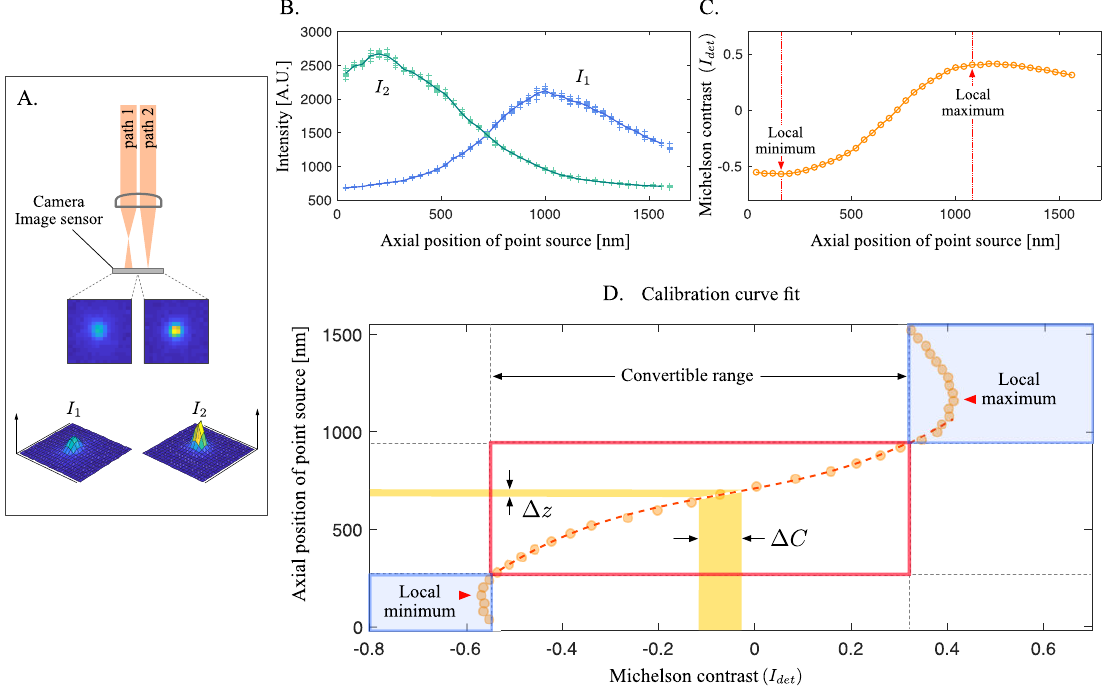
Figure 4. Convertible range of calibration curve acquired by Michelson contrast in dual-focus optics. ( A ) Acquisition of Gaussian peak intensities, I 1 and I 2 , from the images of point source on two different focal planes; ( B ) Changes in I 1 and I 2 during experiment; ( C ) I det for each target axial position; ( D ) Calibration curve between I det and axial coordinate z position as an inverse plot of ( C ). The convertible range of the calibration curve is restricted by the area in which the I det value corresponds to only a single z -position value in the inverse plot (indicated by the red box), which excludes the blue-colored areas where I det can have multiple possible axial positions. The dashed line indicates a third-order polynomial fit. ∆ z can express the resolution in the calibration curve when the image resolution is given as ∆ C in Equation